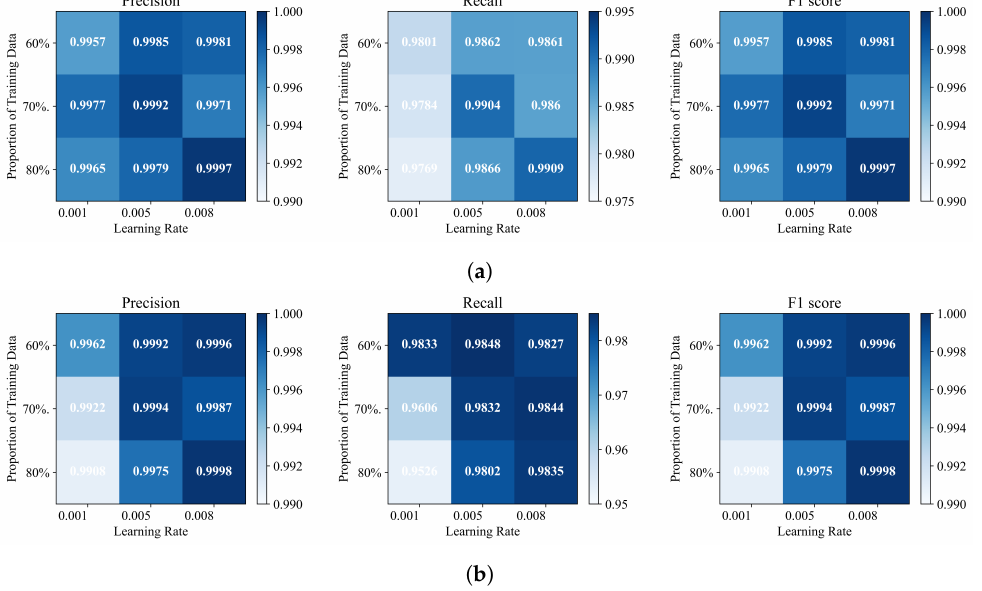
Figure 8. Parameter sensitivity results of the LPSMN model with respect to three metrics. ( a ) Results on WD; ( b ) Results on